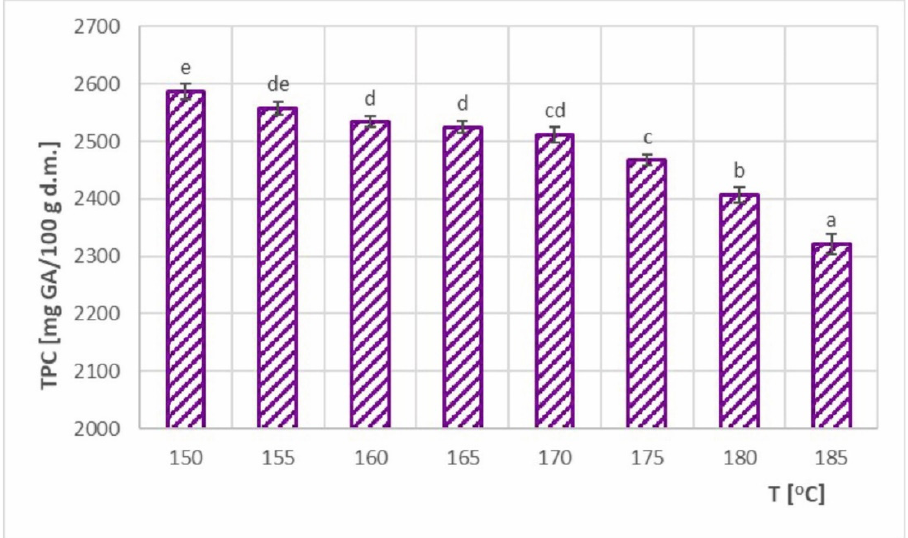
Figure 9. Total polyphenol content (TPC) in spray-dried chokeberry juice at different inlet air temperatures (T); (a, b, c, d, e—different letters show significant differences between mean values ( p ≤ 0.05)).